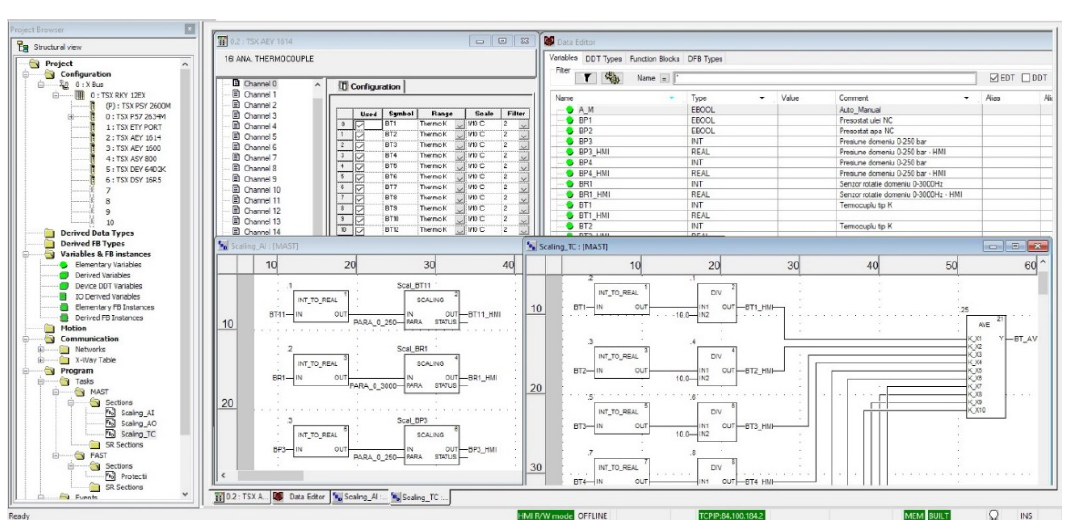
Figure 15. Unity PRO Software—Stirling engine.